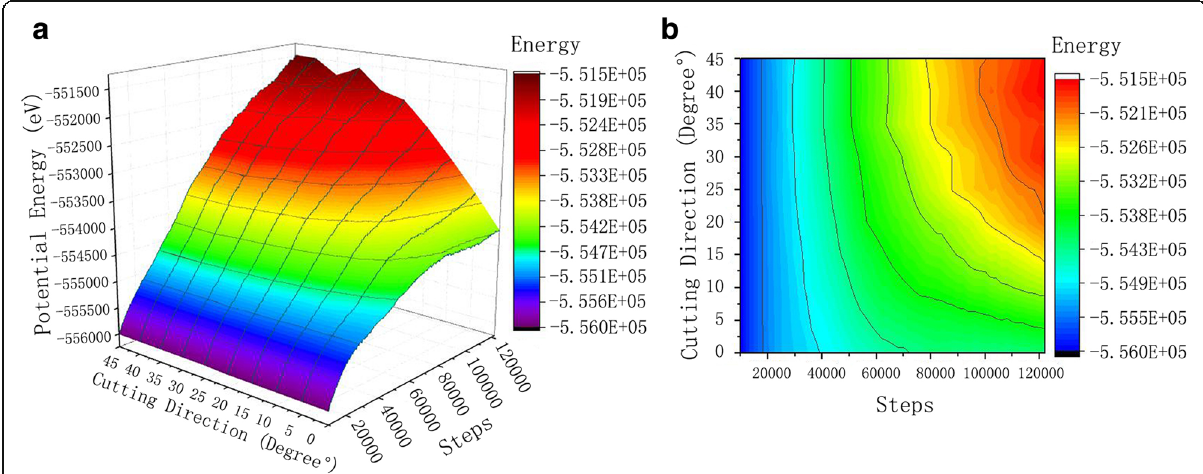
Fig. 8 Potential energy curve of the workpiece. Figure 8 is a graph of potential energy variations at different cutting angles during the cutting process. With the increase in the number of steps for simulation, the potential between the monocrystal copper atoms exhibit workpiece tends to increase. a 3D curve. b Contour